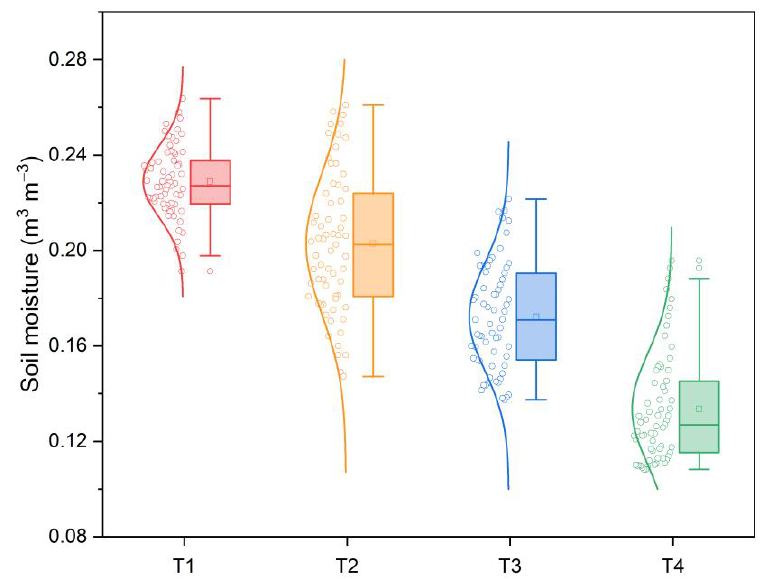
Figure 7. Comparison of the average soil moisture under different water stresses. The soil moisture was represented by the average soil moisture at depths of 10, 20 and 50 cm. The average was calculated using the values of soil moisture from 176 DAP to 240 DAP. DAP means days after planting.